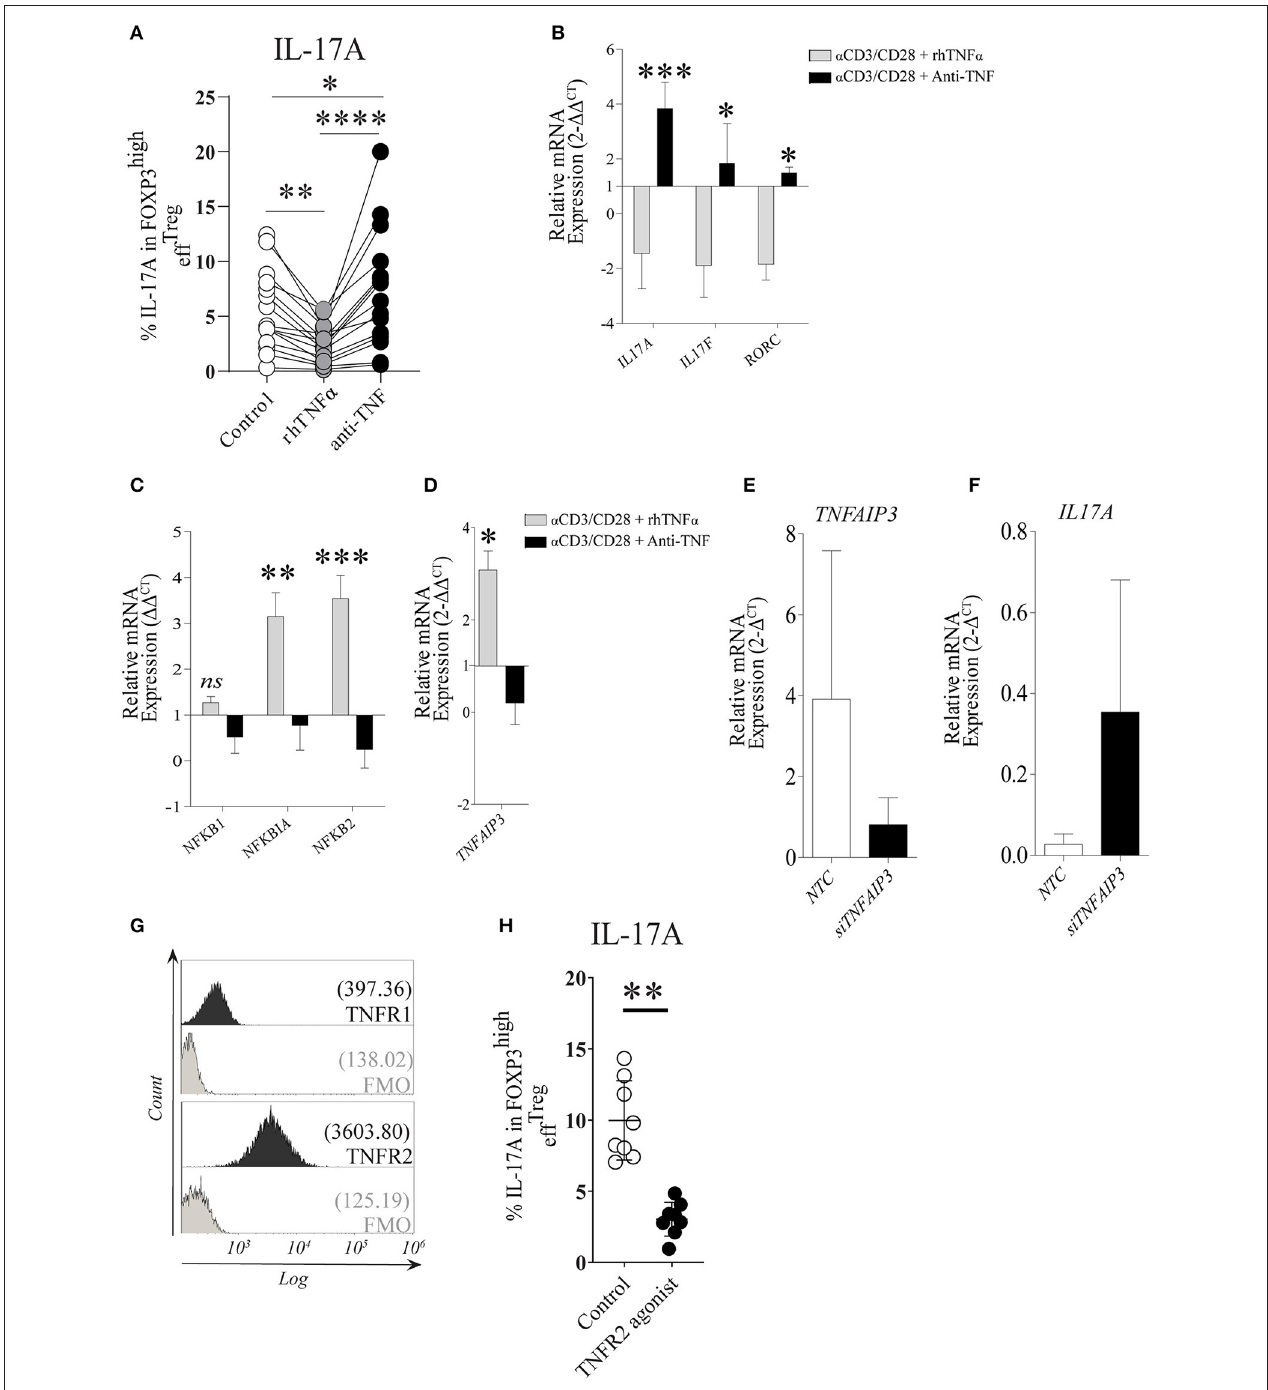
FIGURE 2 | TNF α -TNFR2 signaling reduces IL-17A expression in activated eff Treg, conceivably via the anti-inflammatory regulator TNFAIP3/A20 . (A) Flow cytometry of intracellular IL-17A expression in FOXP3 high eff Treg that were stimulated with α CD3/CD28/rhIL-2 for 5 days in the absence or presence of rhTNF α or anti-TNF ( n = 15). (B) RT-qPCR gene expression of IL-17A, IL-17F, and RORC, (C) NF κ B target genes NFKB1, NFKB1A, NFKB2 ( n = 5), and (D) TNFAIP3 ( n = 8) at day 4 of culture. (E,F) TNFAIP3 and IL-17A gene expression of non-targeting-gene control (NTC) and siTNFAIP3 eff Treg after 6 days under α CD3/CD28/rhIL-2 stimulation ( n = 3). (G) Histogram depicting the expression of TNFR1 and TNFR2 on eff Treg directly after FACS sorting ( n = 9). (H) Flow cytometry of IL-17A expression in FOXP3 high eff Treg that were stimulated with α CD3/CD28 beads plus rhIL-2 with or without TNFR2 agonist for 5 days ( n = 9). All data are shown as mean ± SEM. For statistical analysis, a Friedman test followed by Dunn’s multiple comparison test (A) , a two-way ANOVA followed by a Bonferroni posttest (B,C) , and a Wilcoxon matched-pairs signed-rank test (D,G,H) were used. * p < 0.05, ** p < 0.01, *** p < 0.001, **** p < 0.0001, ns, not significant.